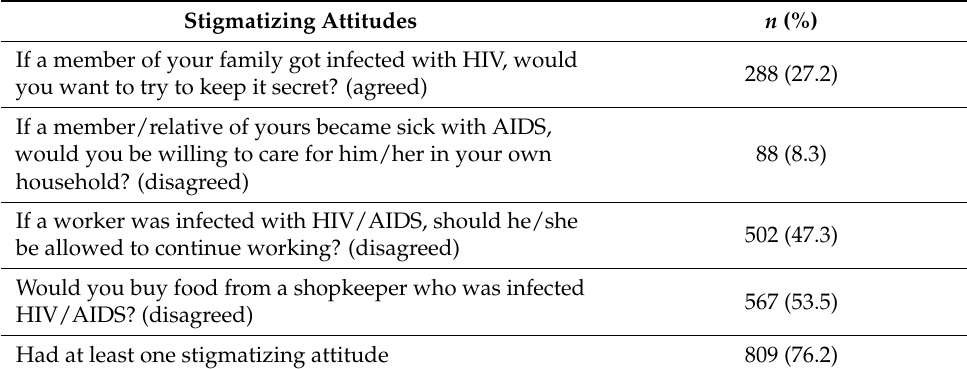
Table 2. Stigmatizing attitudes toward PLWH among women migrant workers ( n =